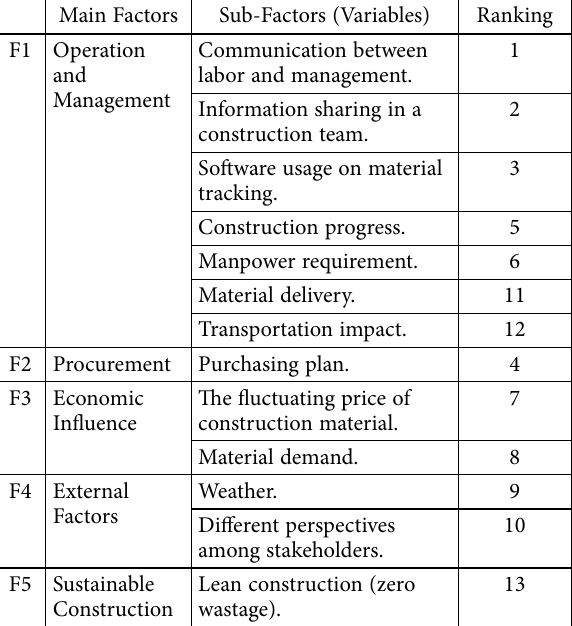
Table 6. List of main factors and variables Main